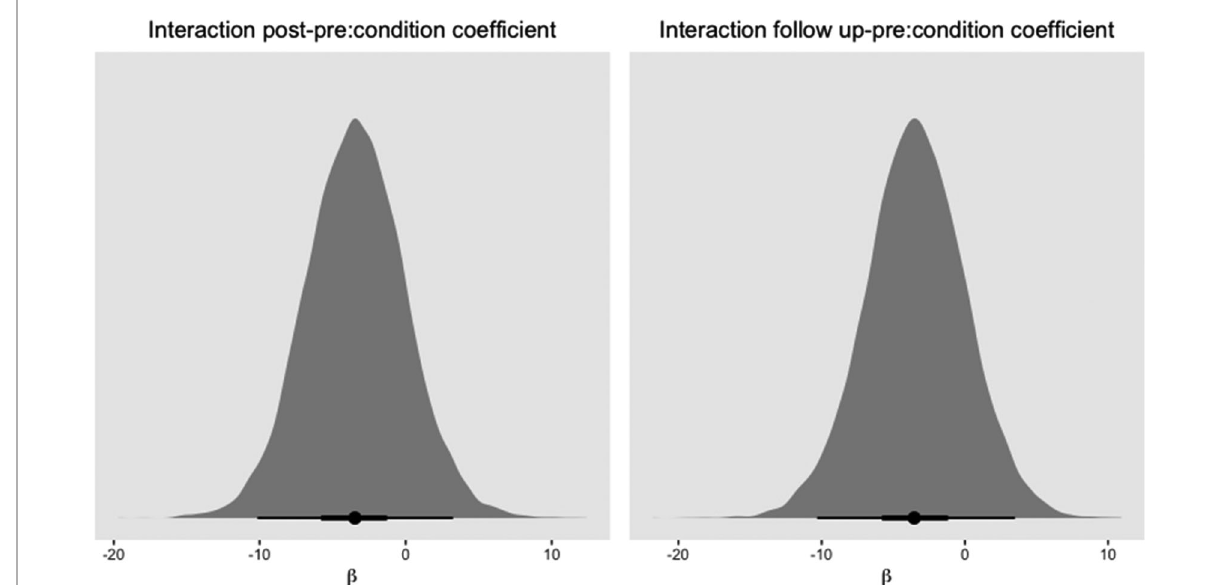
FIGURE 6 Histogram of mode of posterior distribution with 50% and 95% HDI for slopes of condition predicting BDI-II scores. Note that a negative β coef fi cient indicates lower depression symptoms in the 3MR group than in the TAU condition.